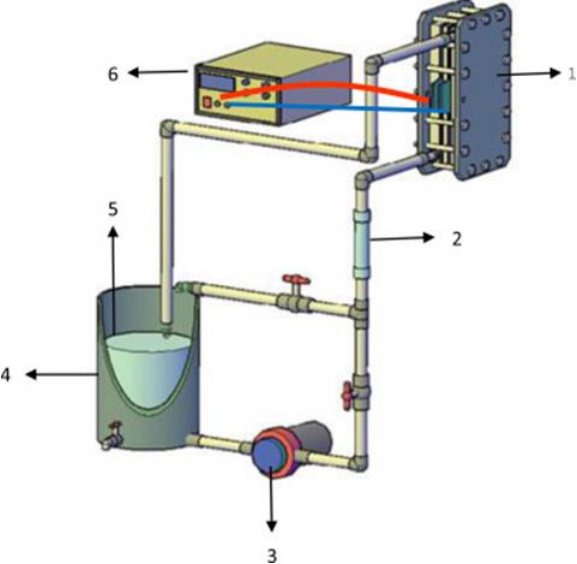
Figure 3. Experimental setup of 4 L undivided filter flow press reactor used for the treatment of paracetamol and diclofenac. 1. flow electrolytic cell, 2. flow meter, 3. peristaltic pump, 4. reservoir, 5. sampling, and 6. power supply. Reprinted from García-Montoya et al. [50], copyright © (2015), with permission from Elsevier.